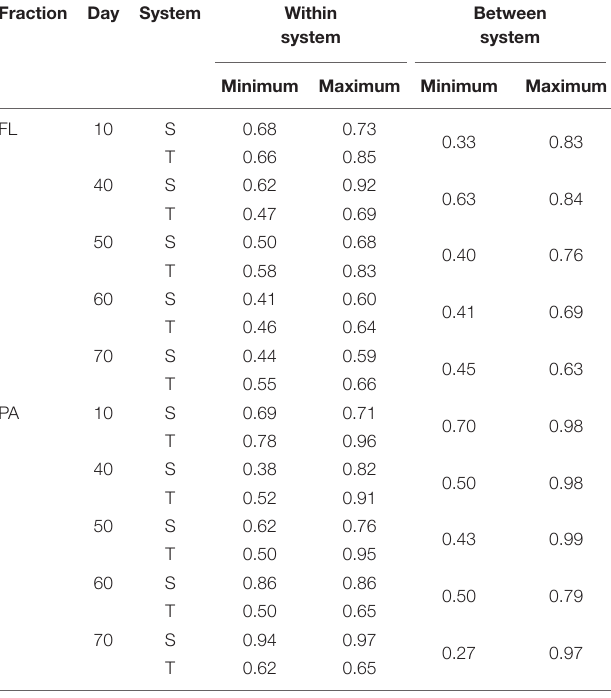
TABLE 4 | Bray–Curtis dissimilarities of bacterial community composition within system (among ponds) and between the systems for each fraction over the time. Fraction Day System Within Between system system Minimum Maximum Minimum